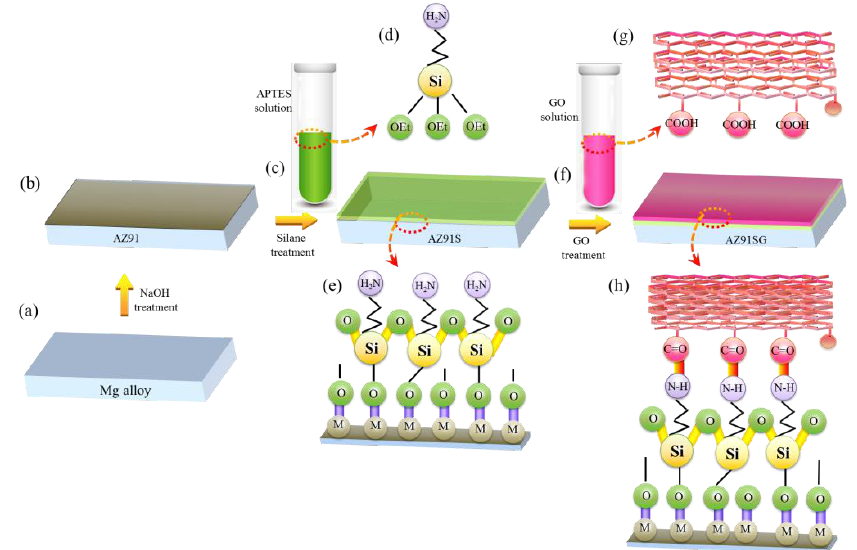
Figure 1. The schematic diagram of proposed layer-by-layer self-assembly lamellar structure between silane and GO sheets on AZ91 Mg alloy substrate. Treatment with ( a, b ) NaOH, ( c – e ) silane, ( f – h ) GO, respectively.